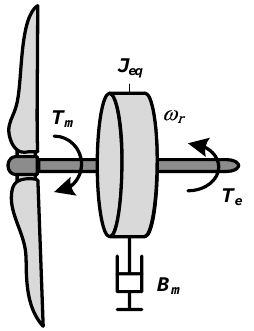
Figure 4. One-lumped mass model of wind turbine generator.